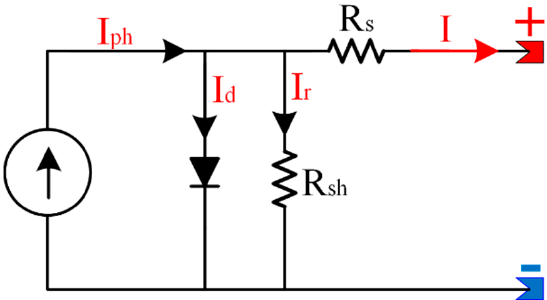
Figure 1. Equivalent circuit of the solar cell model.